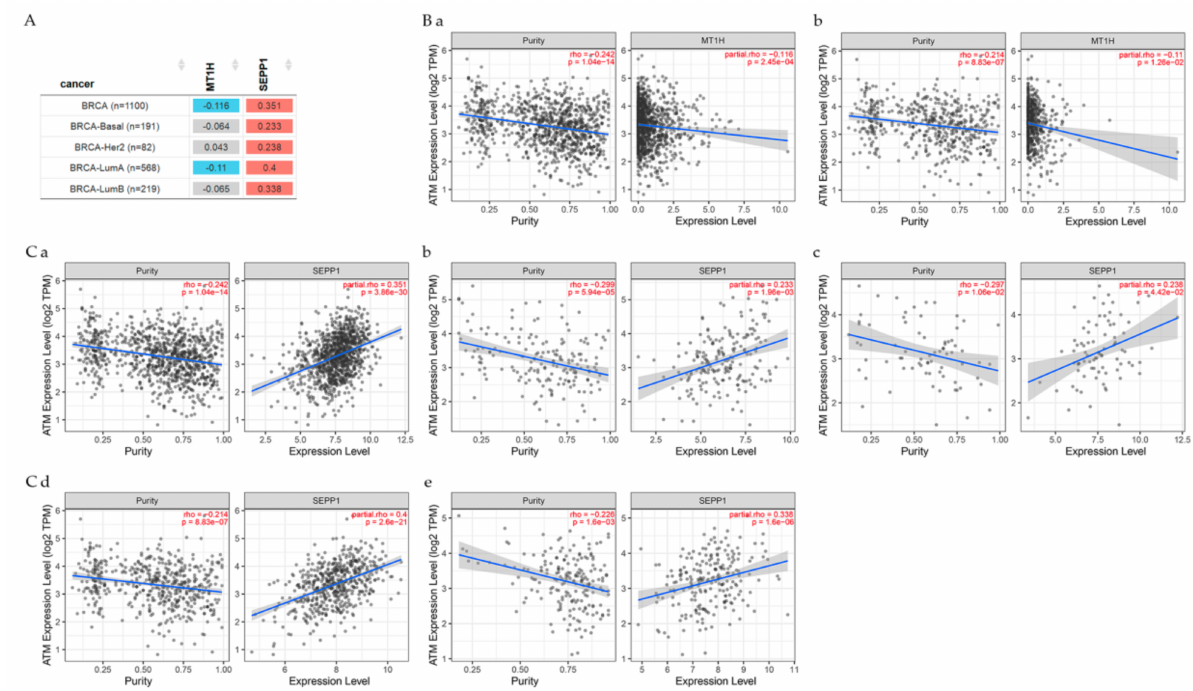
Figure 6. ( A ) The table explores the correlations between ATM gene expression and other genes in BRCA patient types. These figures show the correlation between ATM gene expression and ( B ) MT1H in ( a ) All BRCA and ( b ) BRCA-LumA; ( C ) SEPP1 in ( a ) All BRCA, ( b ) BRCA-Basal, ( c ) BRCA-Her2, ( d ) BRCA-LumA, and ( e )